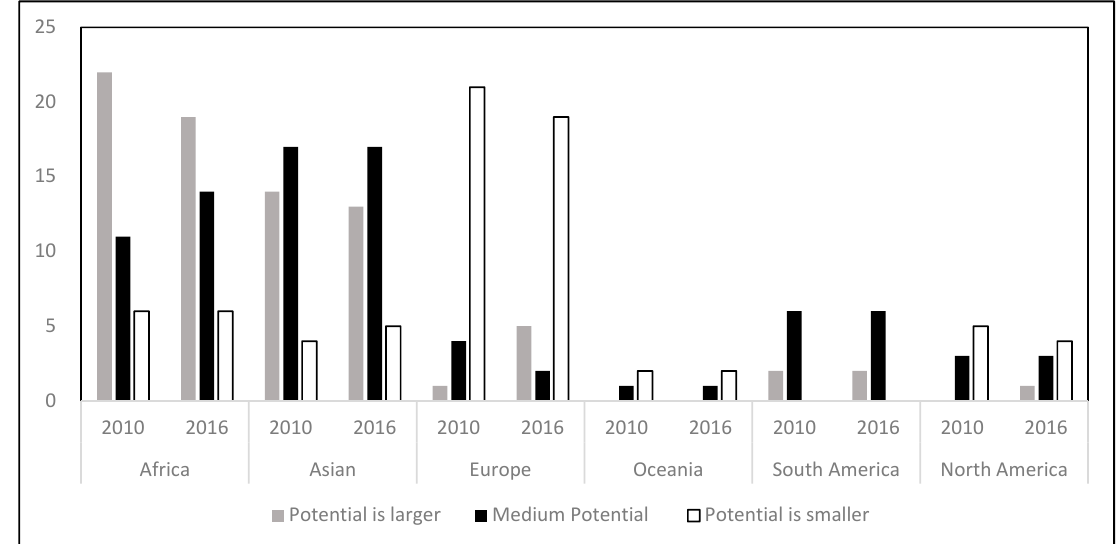
Figure 4. Distribution of production conditions within “the belt and road initiative” countries.